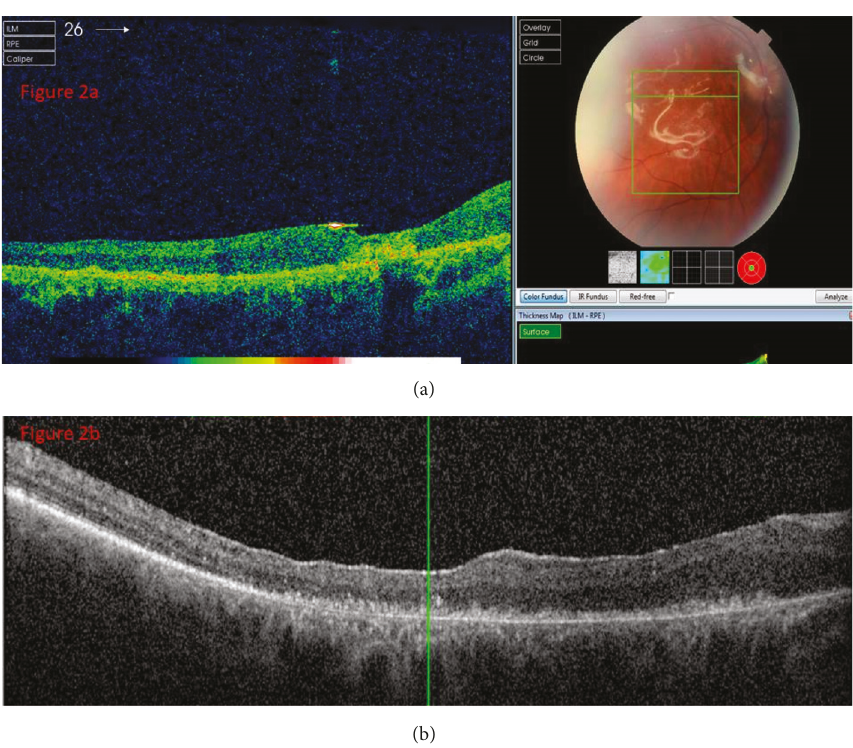
Figure 2: OCT demonstrating the closure of the FTMH before (a) and after (b) silicone oil